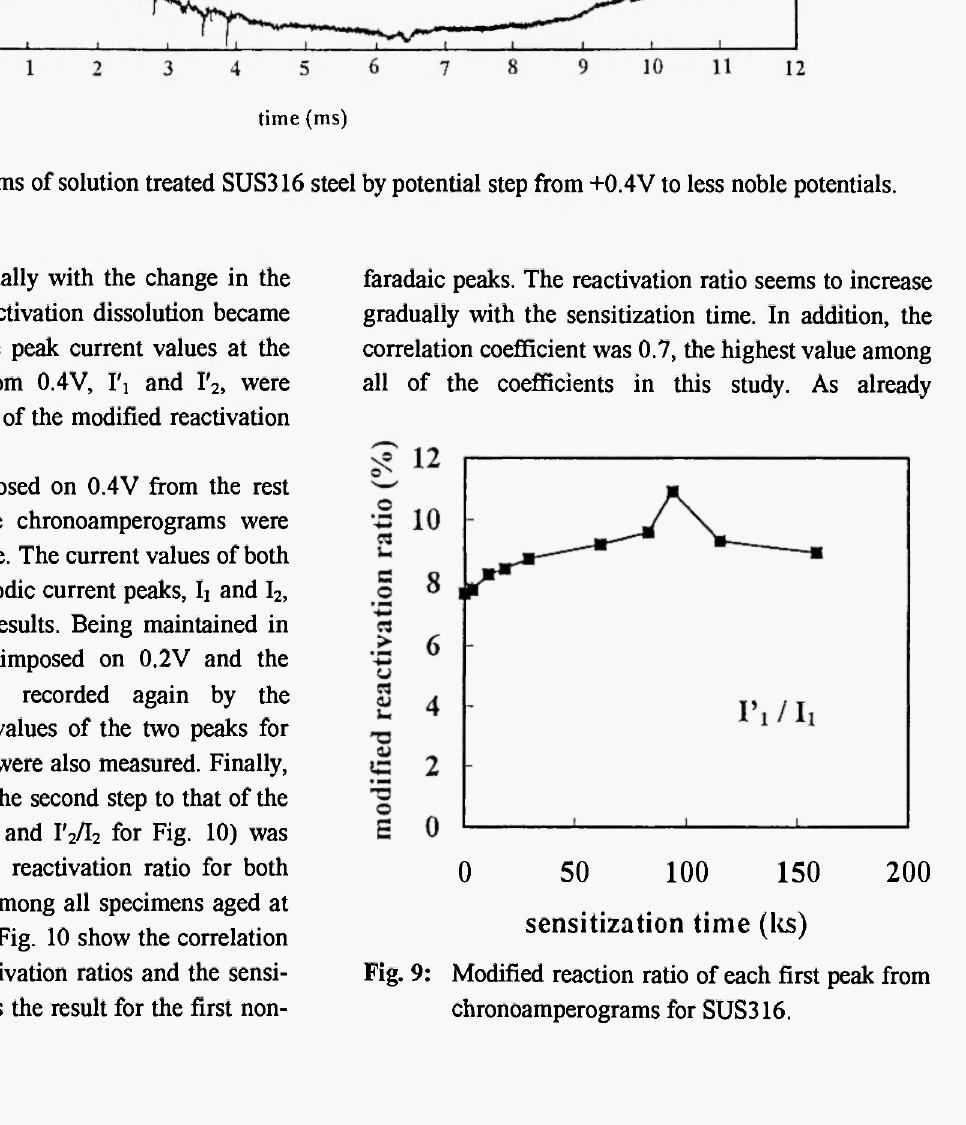
Fig. 9: Modified reaction ratio of each first peak from chronoamperograms for